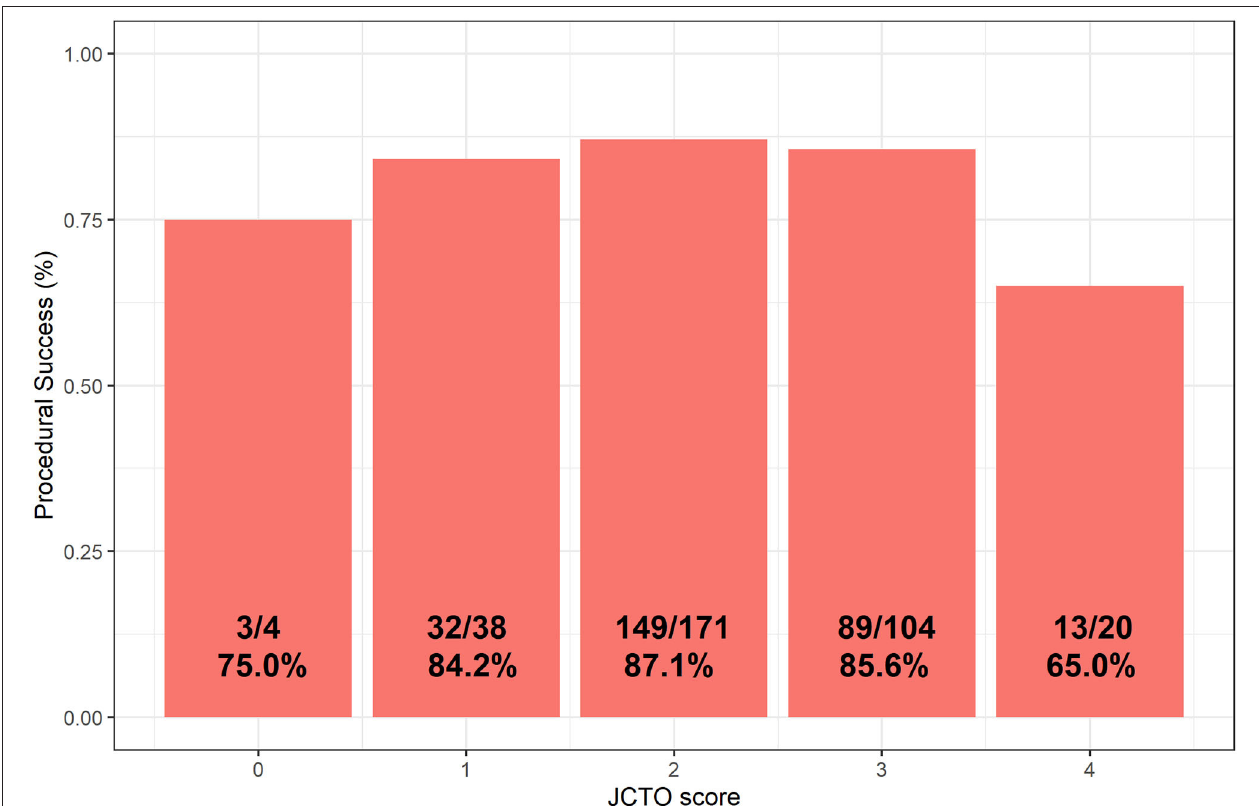
FIGURE 2 | Distribution chart showing procedural CTO success as a function of JCTO score. CTO, chronic total obstruction.